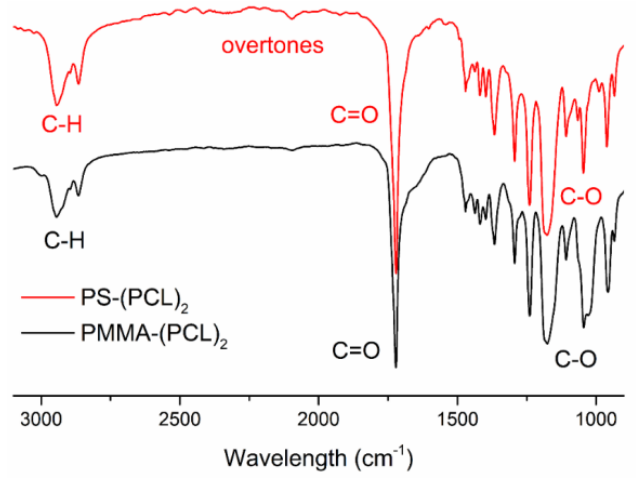
Figure 2. FT-IR spectra of PMMA-(PCL) 2 and PS-(PCL) 2 .